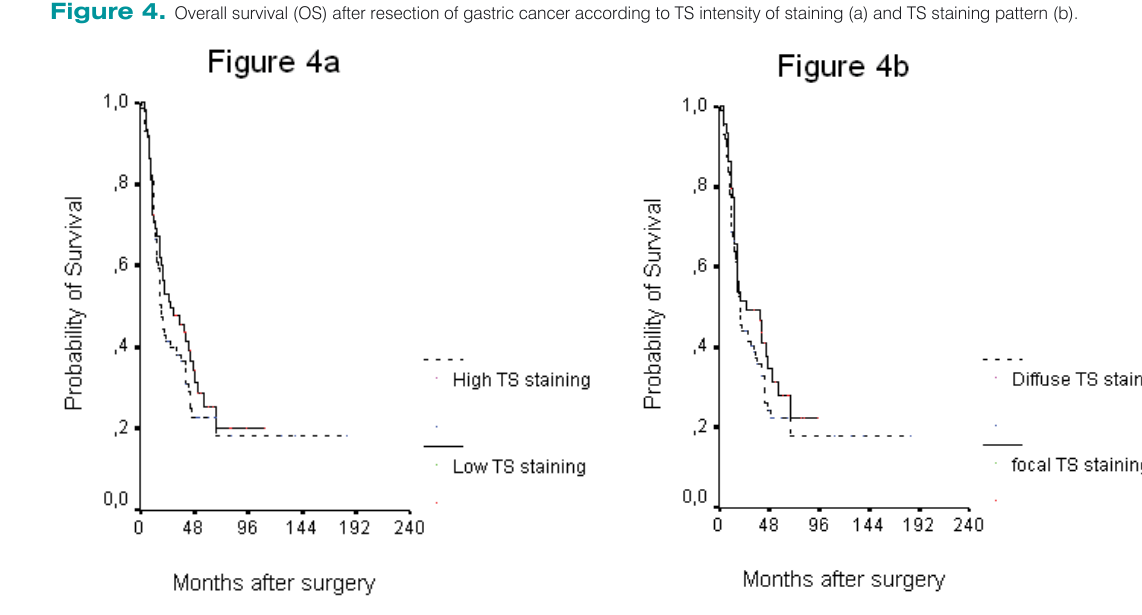
Figure 4. Overall survival (OS) after resection of gastric cancer according to TS intensity of staining (a) and TS staining pattern